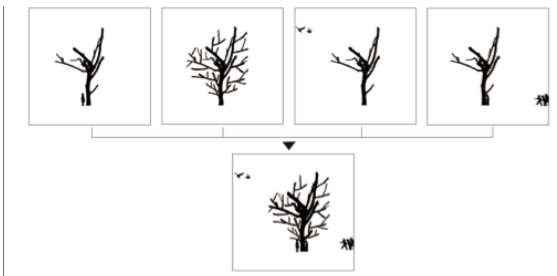
FIGURE 3 | Each story can be triggered by four diferent sensors and can